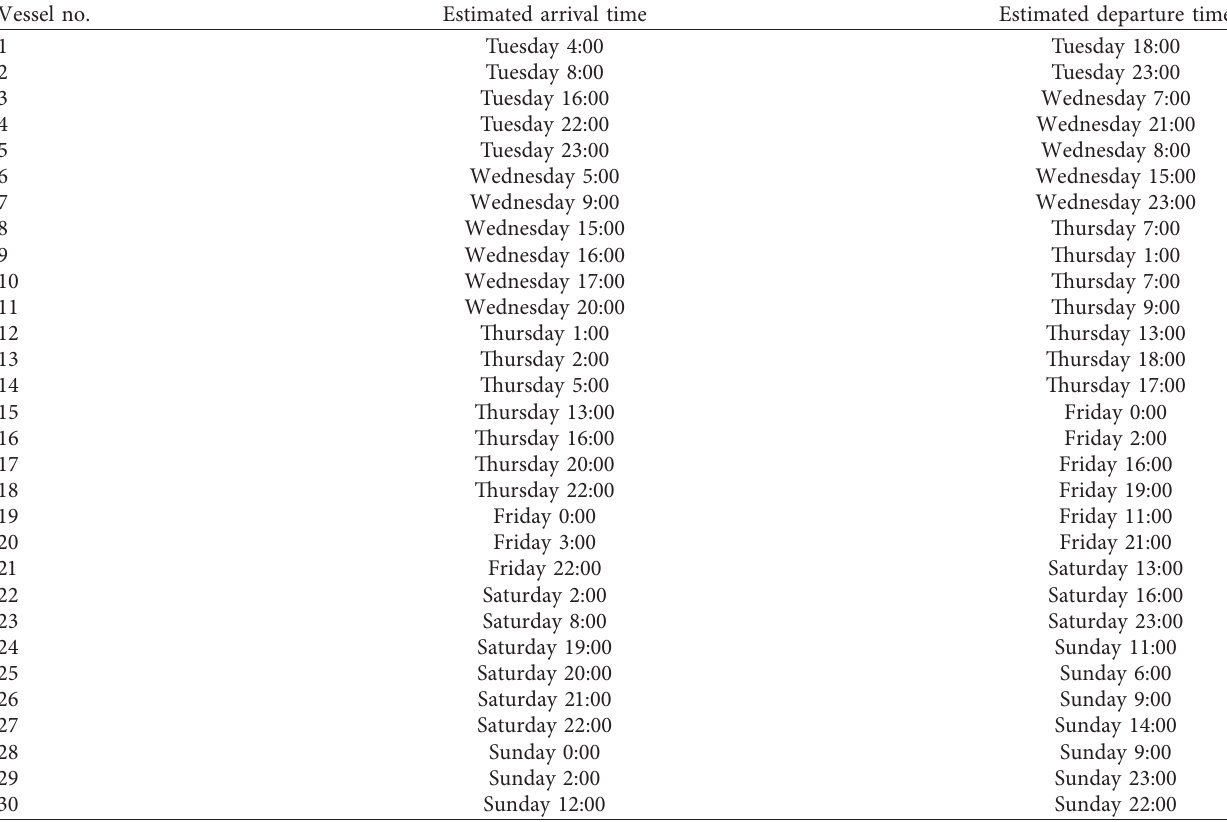
Table 2: Estimated times of arrival and departure of vessels.